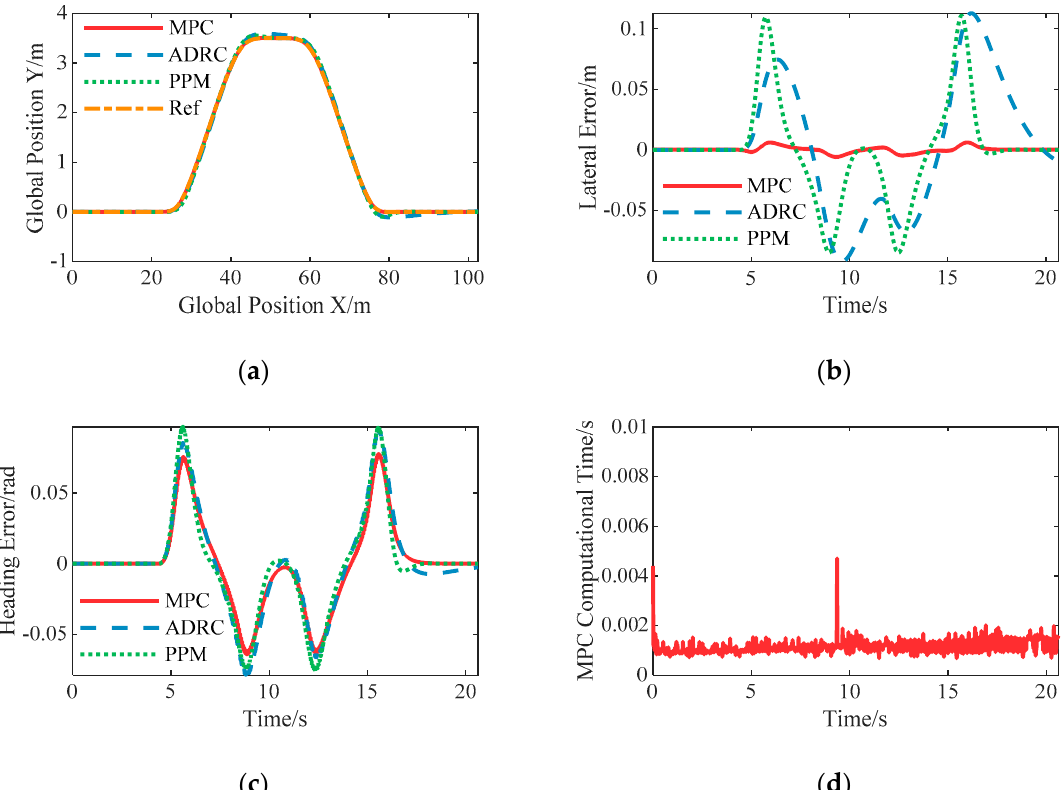
Figure 9. Simulation results of double lane change with constant speed 5 m/s: ( a ) The spatial path of the vehicle following the given path; ( b ) The resulting lateral error; ( c ) The resulting heading angle error; ( d ) The computational time of the proposed LPV-MPC controller.